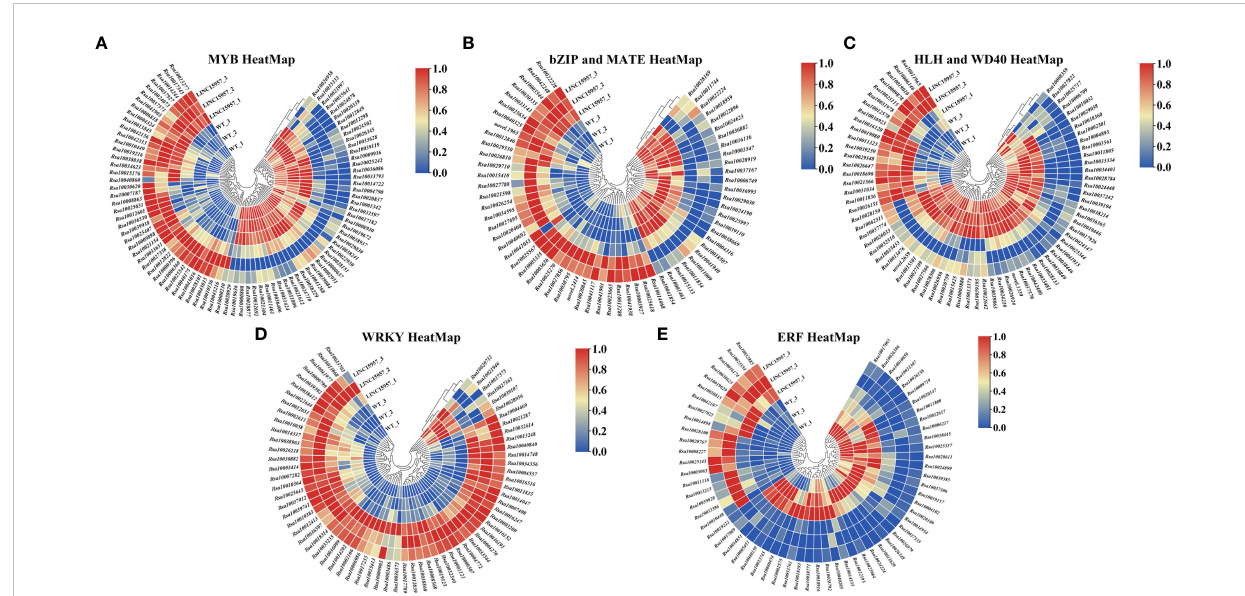
FIGURE 5 Heat-map depicting normalized log 2 -fold changes in mRNA expression inferred from RNAseq data for transcripts involved in transcription factor family. (A) Differential MYB transcription factor heat-map. (B) Differential bZIP and MATE transcription factor heat-map. (C) Differential HLH and